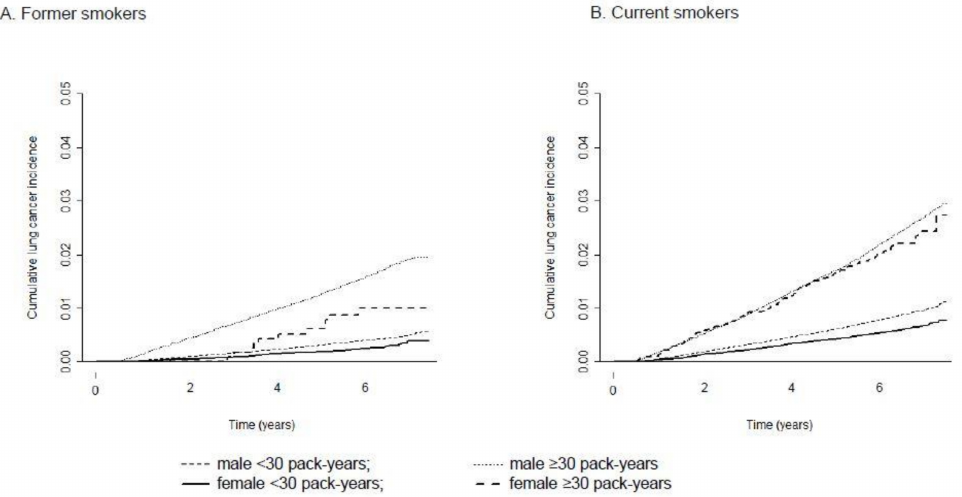
Figure 2. Cumulative lung cancer incidence in men and women according to smoking status and pack-years. ( A ) Former smokers and ( B ) Current